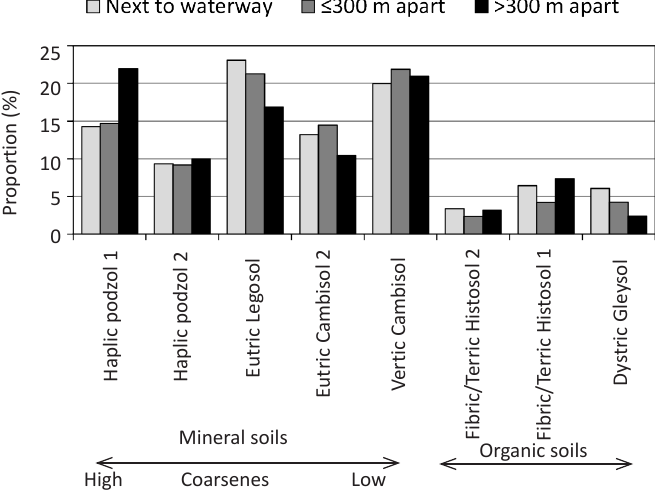
Fig. 6. Frequency of different soil types in fields next to waterway, up to 300 m from waterway and elsewhere. Data from Luke Soil Database (Lilja et al.